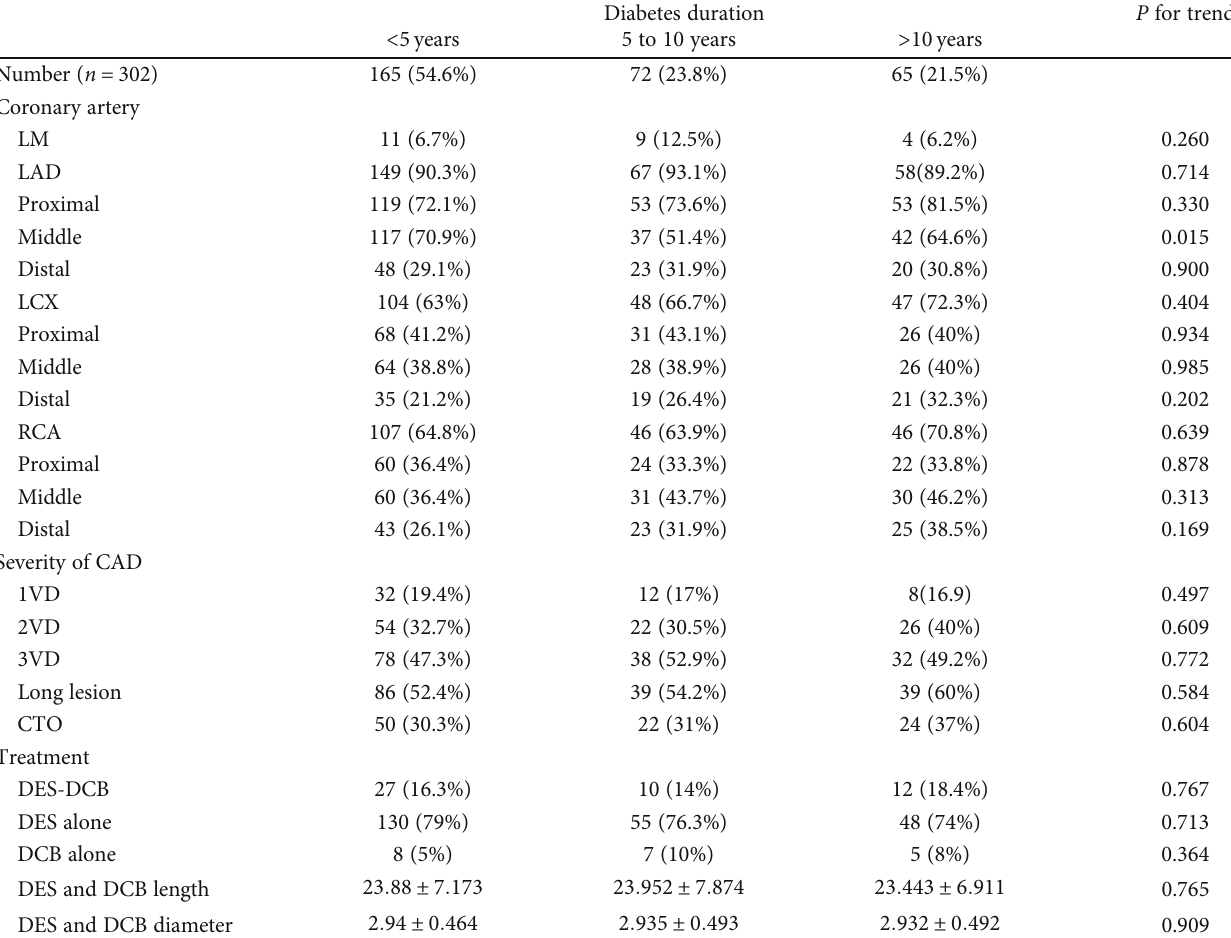
Table 2: Baseline lesions characteristics and devices